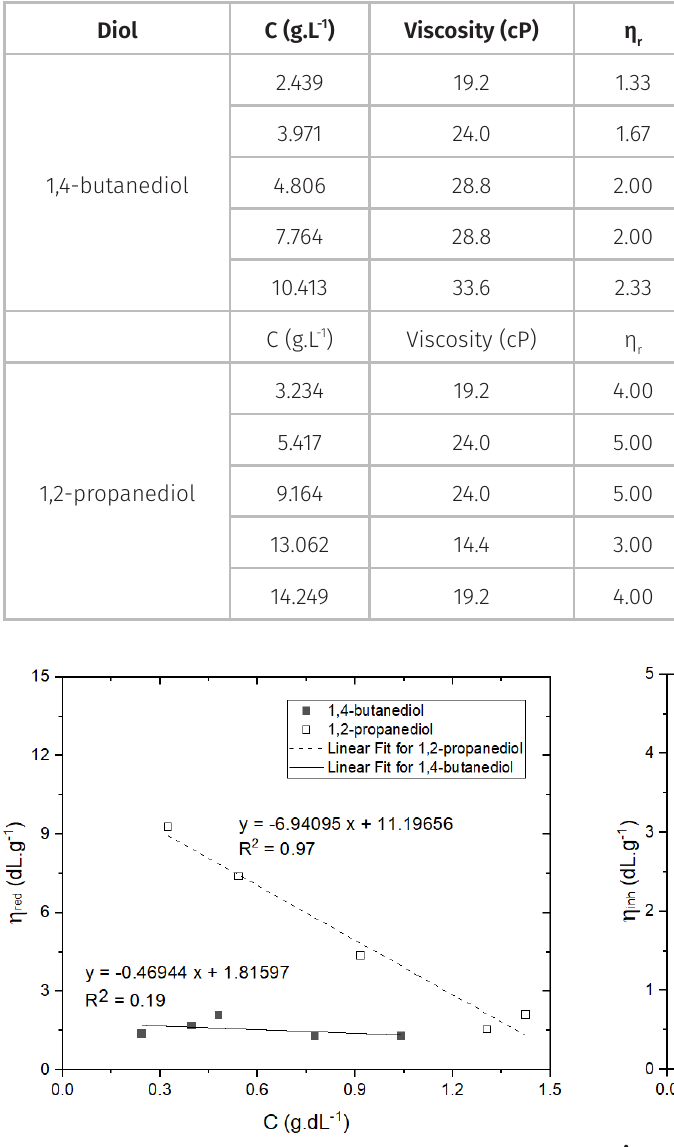
Figure 5. Data adjustment of Kraemer Equation for inherent viscosity versus concentration for diluted HTPB resin solutions in 1,4-butanediol and 1,2-propanediol.